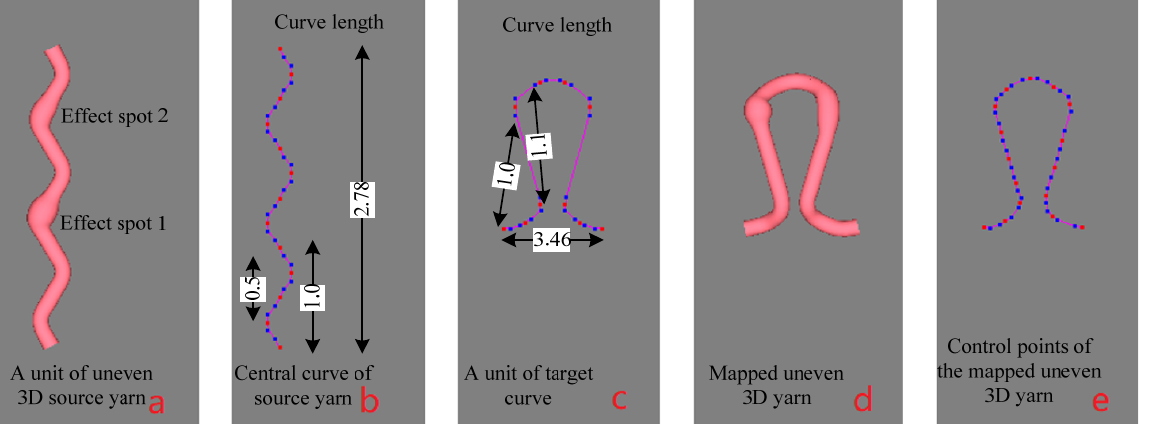
Figure 4. The procedure of changing the central line of a 3D slub yarn.